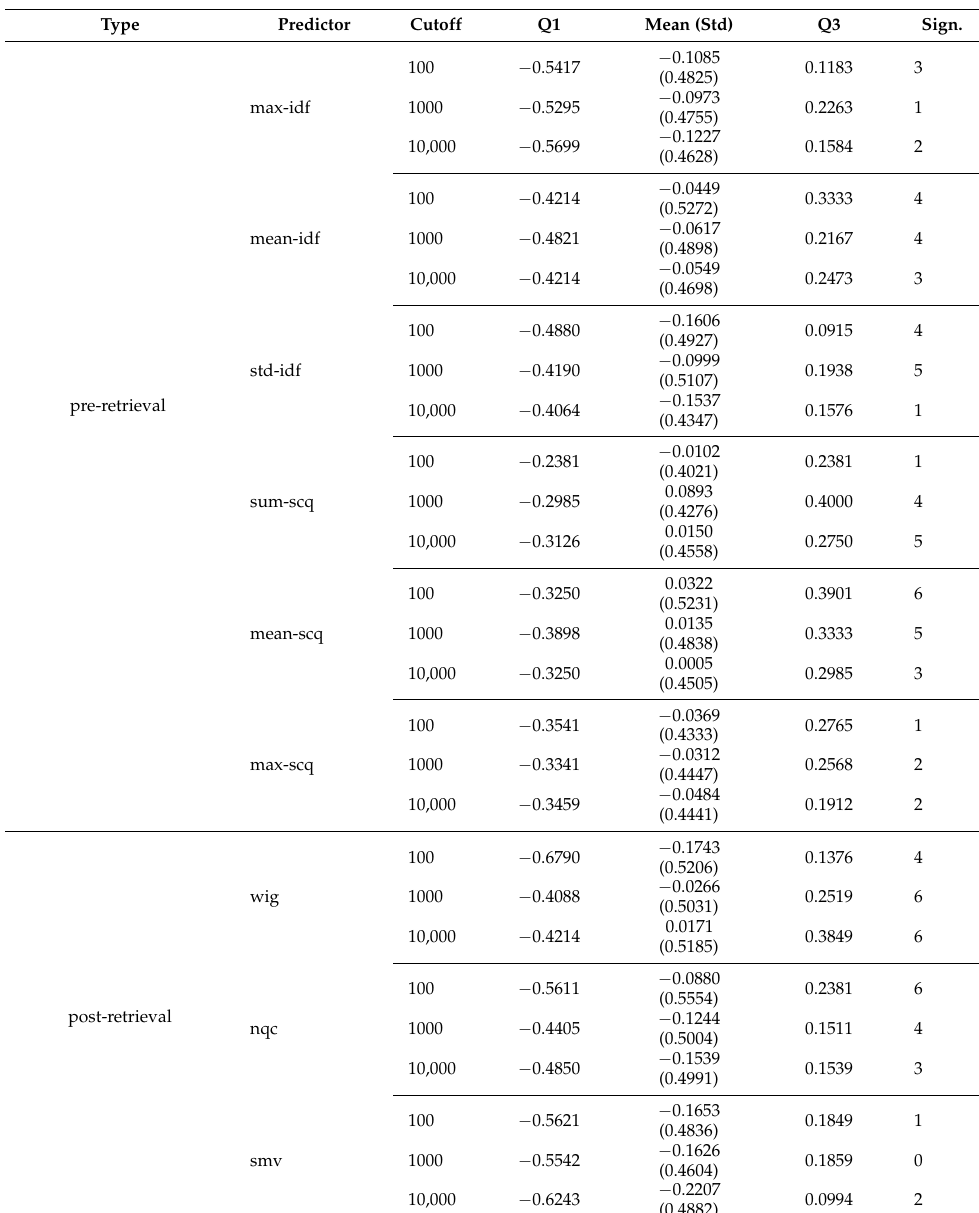
Table 3. Performance achieved by traditional predictors, applied to our specific case. Each predictor has been used to predict the performance of the different formulations. We report the mean score and standard deviation of the correlation computed over the different topics. We also report the first quartile, third quartile and number of topics (over the 50 available) for which the correlation between the predicted and observed recalls for their (re)formulations is significantly greater than